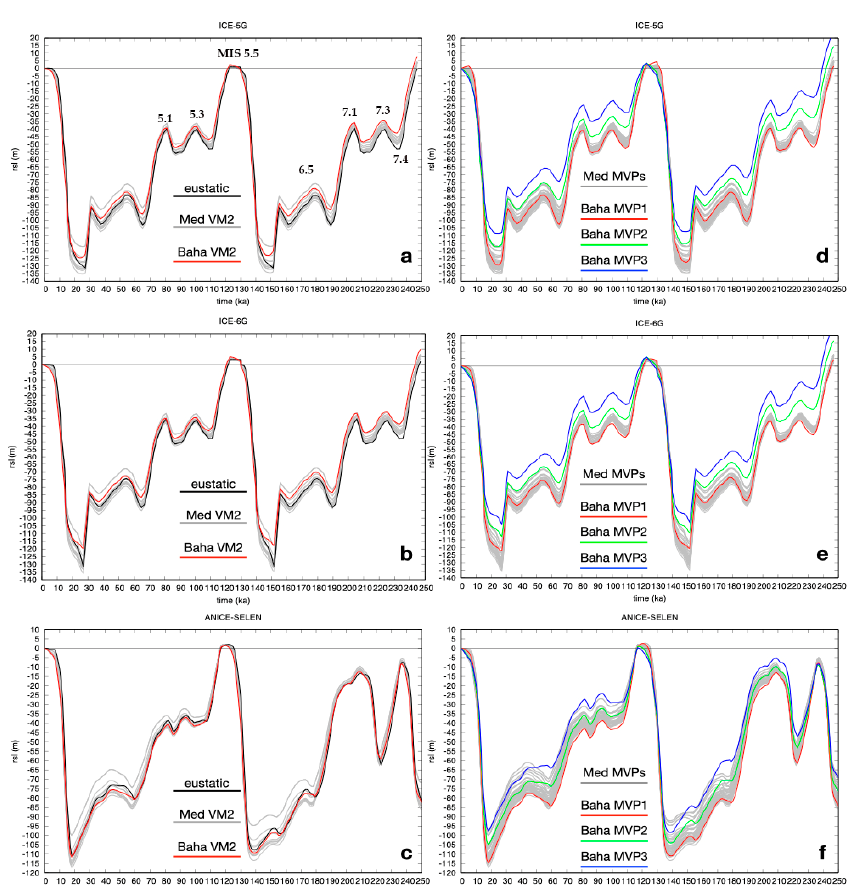
Figure 7. Cumulative predicted relative sea level (RSL) curves for ICE-5G ( a , d ), ICE-6G ( b , e ), and ANICE-SELEN ( c , f ) ice sheet models, in combination with different mantle viscosity profiles. The gray curves are for each site within the Mediterranean Sea, the red curves are for the Bahamas, and the black curves represent the eustatic signal (with respect to the present-day ocean function) for each ice sheet model.